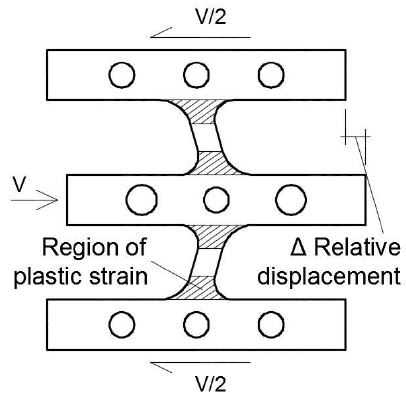
Figure 4. Experimental setup used during the cycling tests.